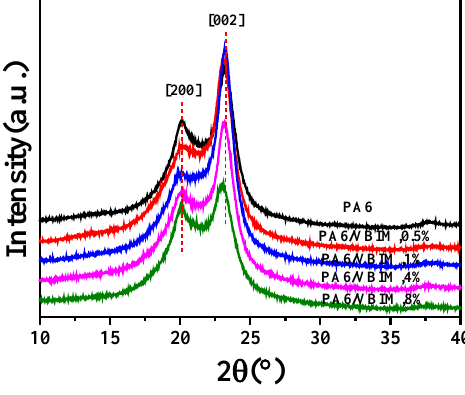
Figure 2. XRD patterns of neat PA6 and the PA6/VBIM blends.